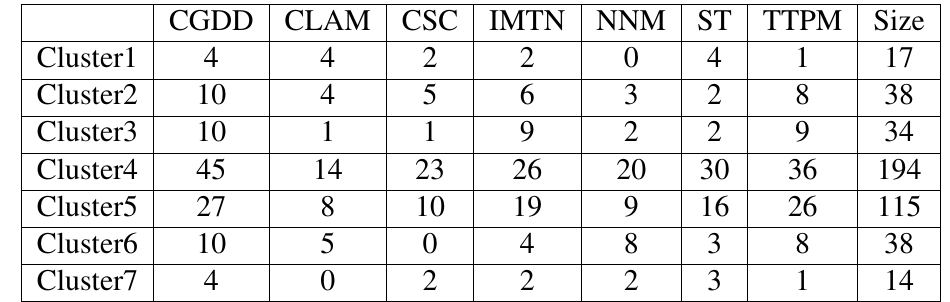
Table 1: Profile of the 450 genes from the mouse cerebellum development dataset